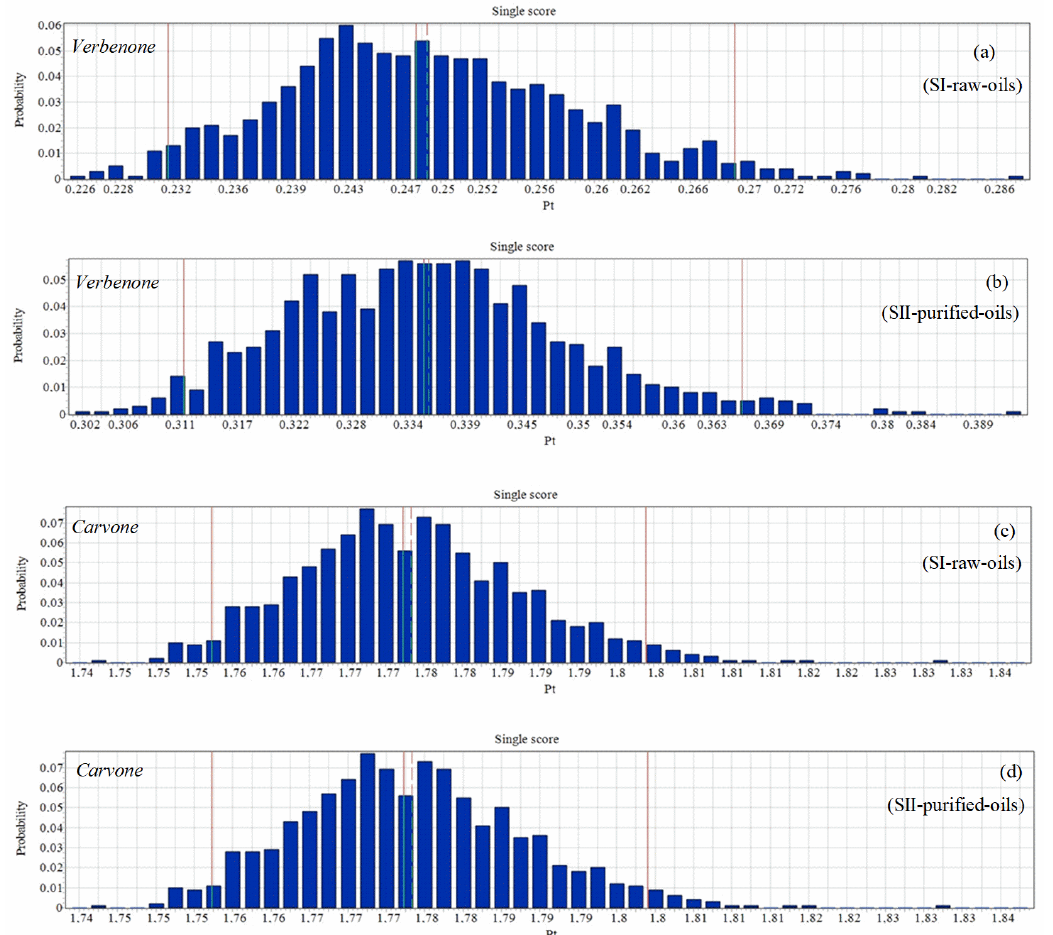
Figure 13. Uncertainty analysis of the process for the production of verbenone ( a , b ) and carvone ( c , d ). Assessment methods: ReCiPe 2016 Endpoint (H) V1.06/World (2010) H/A; number of bins: 50, visible interval: 99.9%, confidence interval: 95%. Functional unit: 1 kg of ketone/batch. Table 3. Statistical parameters (by score) of the uncertainty analysis of the processes. Assessment methods: ReCiPe 2016 Endpoint (H) V1.06/World (2010) H/A; number of bins: 50, visible interval: 99.9%, confidence interval: 95%. Functional unit: 1 kg of ketone/batch.